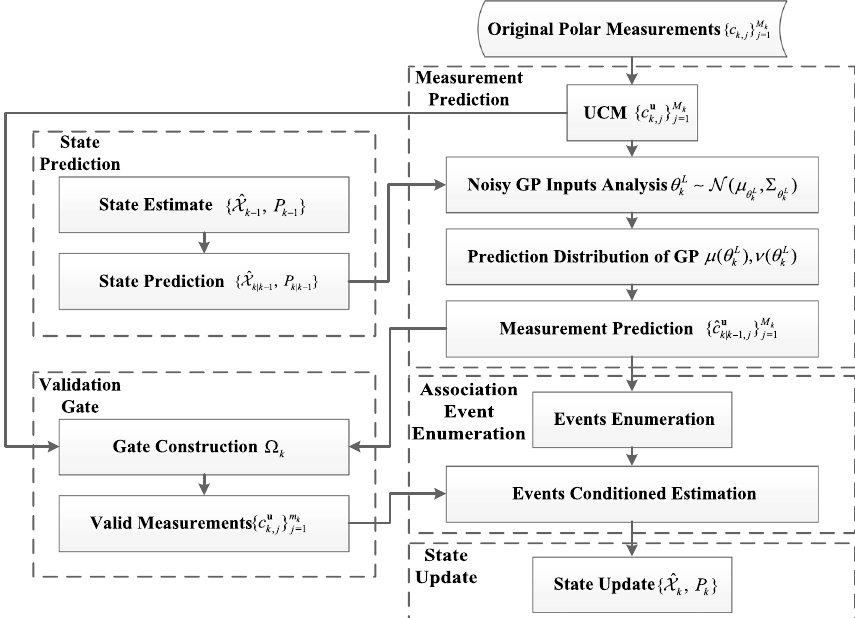
Fig. 3 Block diagram of the